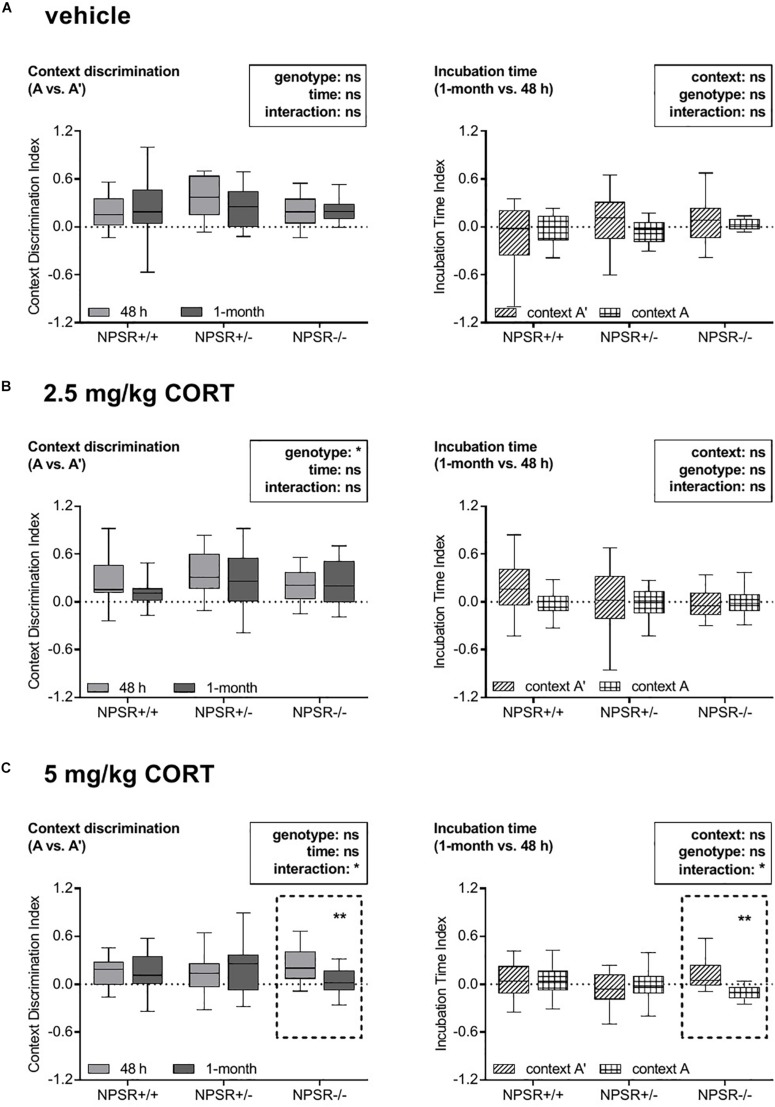
Effects of corticosterone treatment on specificity and strength of contextual fear memory in NPSR-deficient mice. The left panel depicts the context discrimination index (A vs. A′) and the right panel depicts the incubation time index (1 month vs. 48 h). Injections of (A) vehicle and (B) 2.5 mg/kg CORT did not affect specificity or strength of the contextual memory. However, injections of (C) 5 mg/kg CORT significantly decreased both specificity and strength of the contextual memory in NPSR−/− mice (dashed frames), suggesting a generalization of the fear memory, but not in NPSR+/+ and NPSR+/− mice. Group sizes: NPSR+/+: n = 65; NPSR+/−: n = 62; NPSR−/−: n = 46. Data are illustrated with box plots (median, quartiles) and Tukey’s whiskers. *p < 0.05; **p < 0.01; post hoc Holm-Sidak’s comparisons after ANOVA.